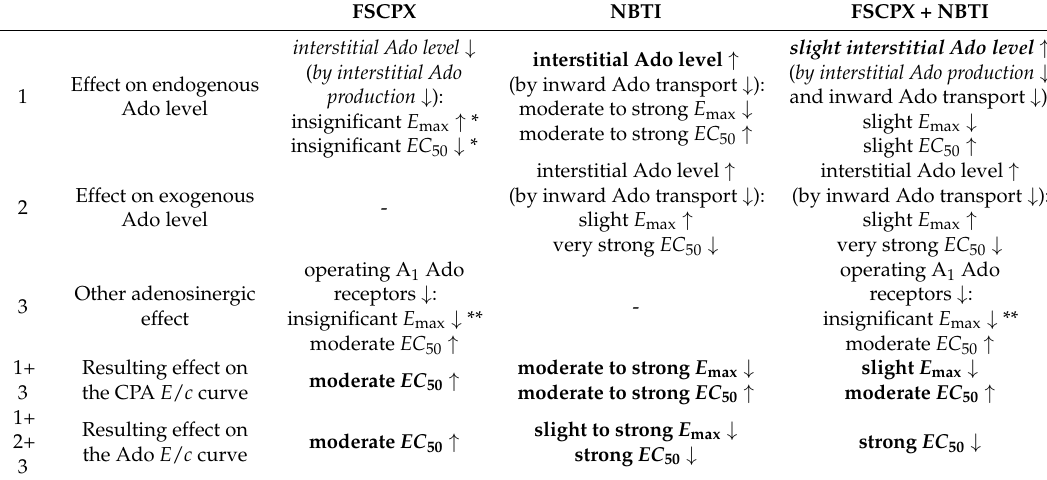
Table 3. Influence of FSCPX and NBTI on the main empirical parameters of CPA and adenosine concentration-response ( E / c ) curves describing the adenosinergic control of atrial